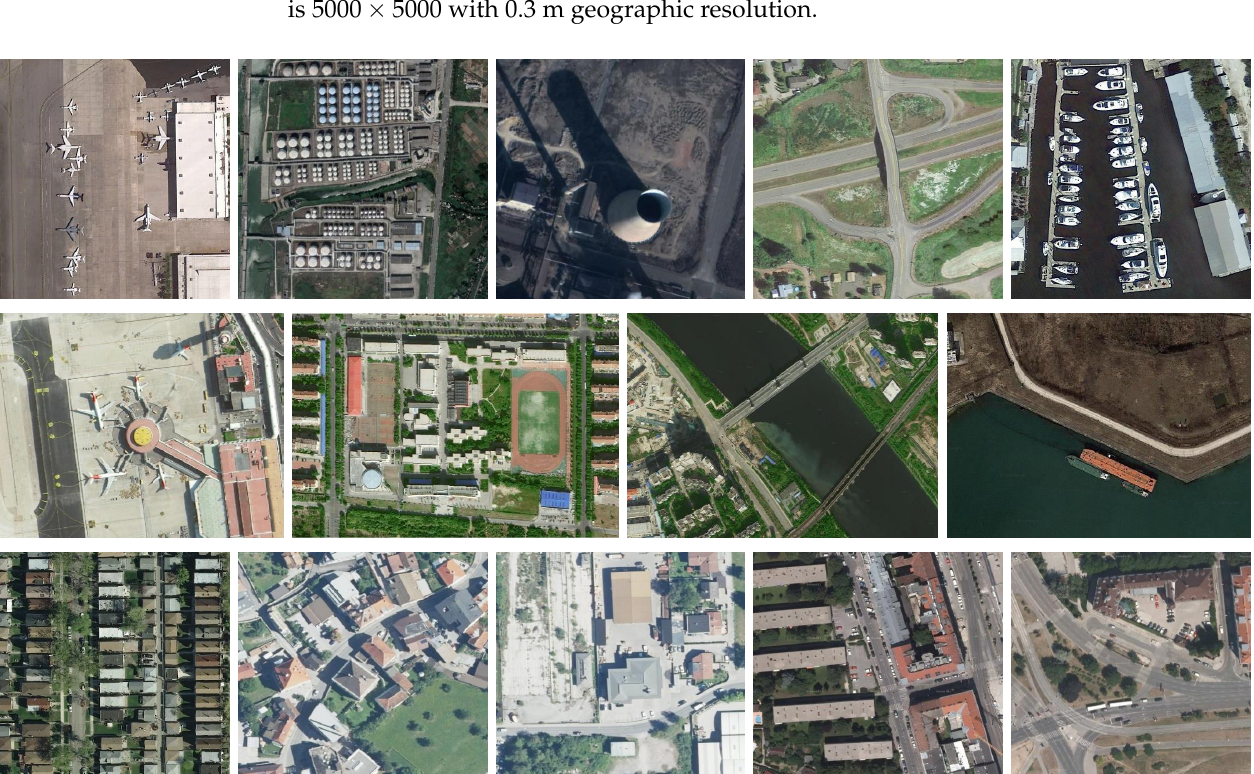
Figure 6. Examples of the three experimental datasets. The examples from top row to bottom row, respectively, belong to the DIOR [71], HRRSD [72], and AIBD